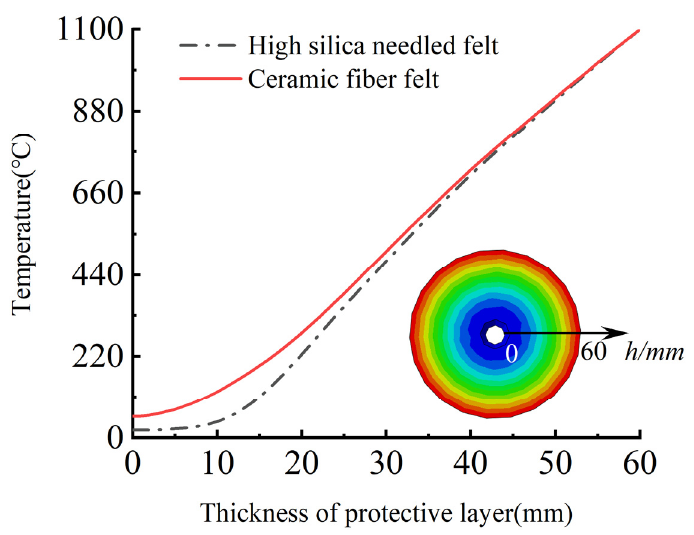
Figure 24. Variation of temperature along the thickness direction of fire ‐ retardant materials during heating for 2 h.